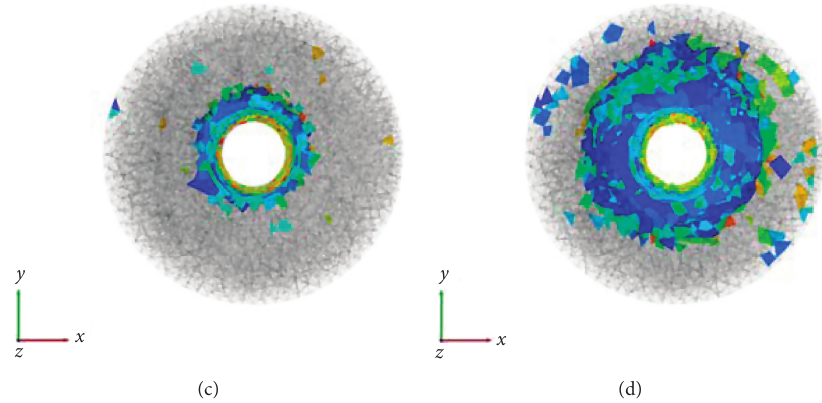
Figure 12: Top view of the rock fragments at four different states for the TWC test with rock sample containing an initial crack.